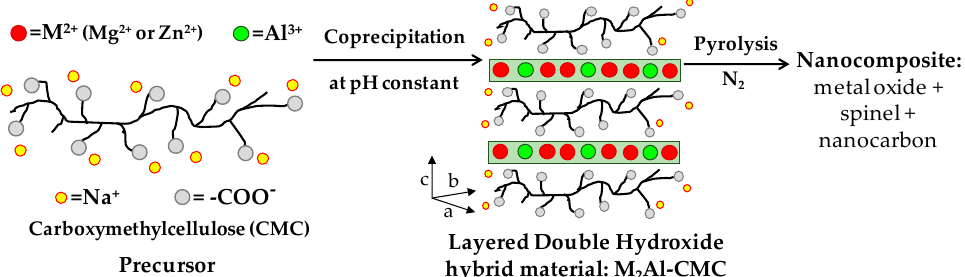
Figure 2. Schematic representation of the two-step synthetic approach used to produce MMO/carbon nanocomposites from layered double hydroxides.